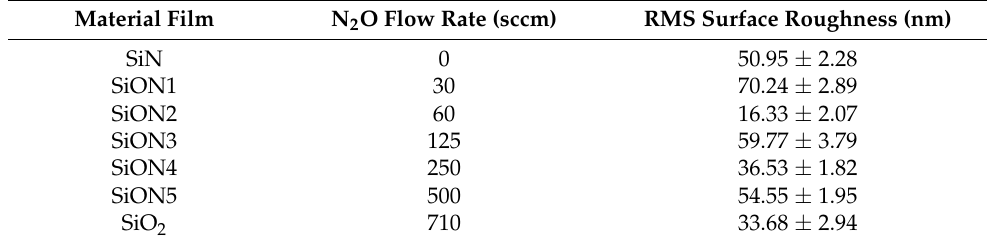
Table 1. RMS Surface roughness (nm) of SiN, SiO, and SiON films.